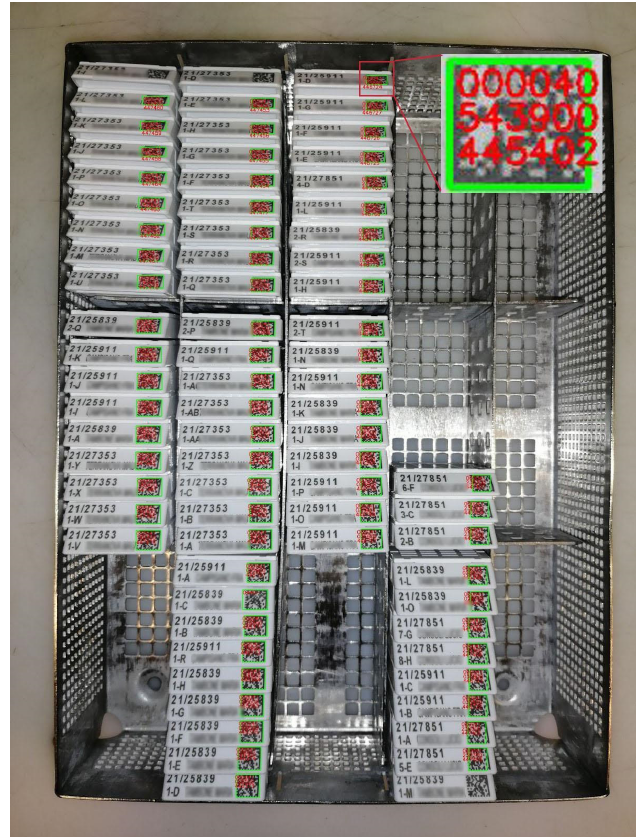
Figure 5. The reading process of barcodes directly from the rack containing the blocks during the processing phase after the digital transition. In the upper right inset the code extracted from the 2D barcode directly in the LIS.